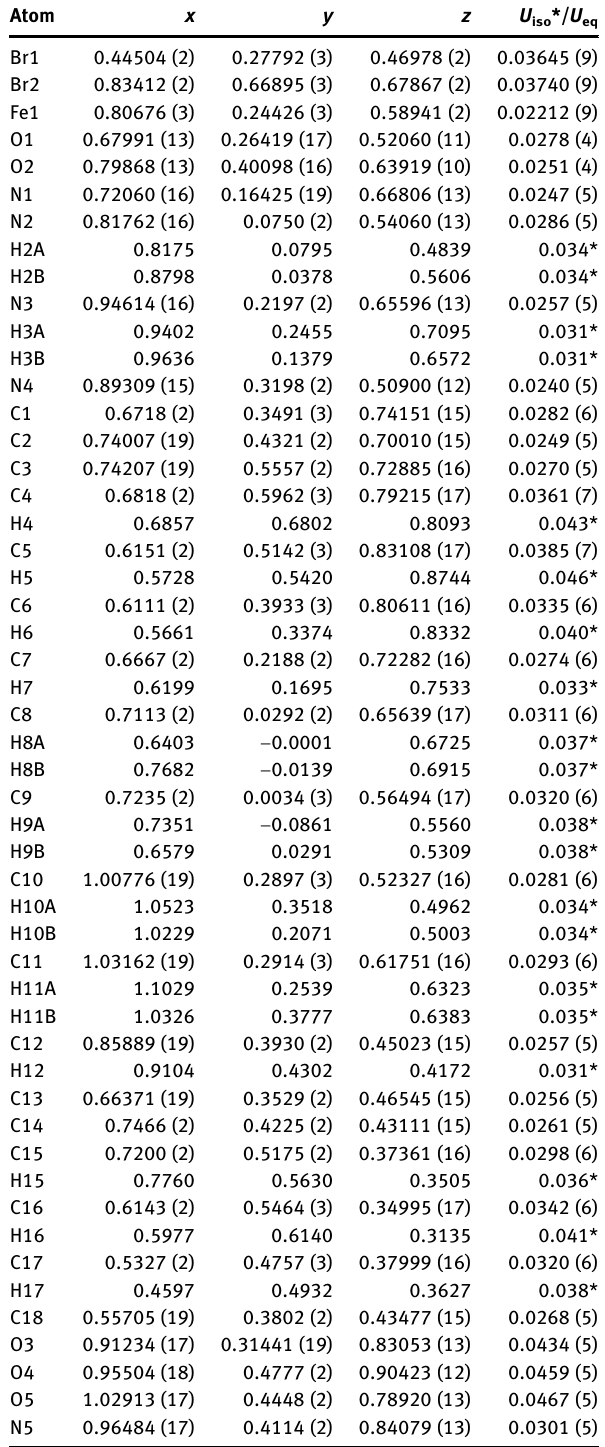
Table  : Fractional atomic coordinates and isotropic or equivalent isotropic displacement parameters (Å 